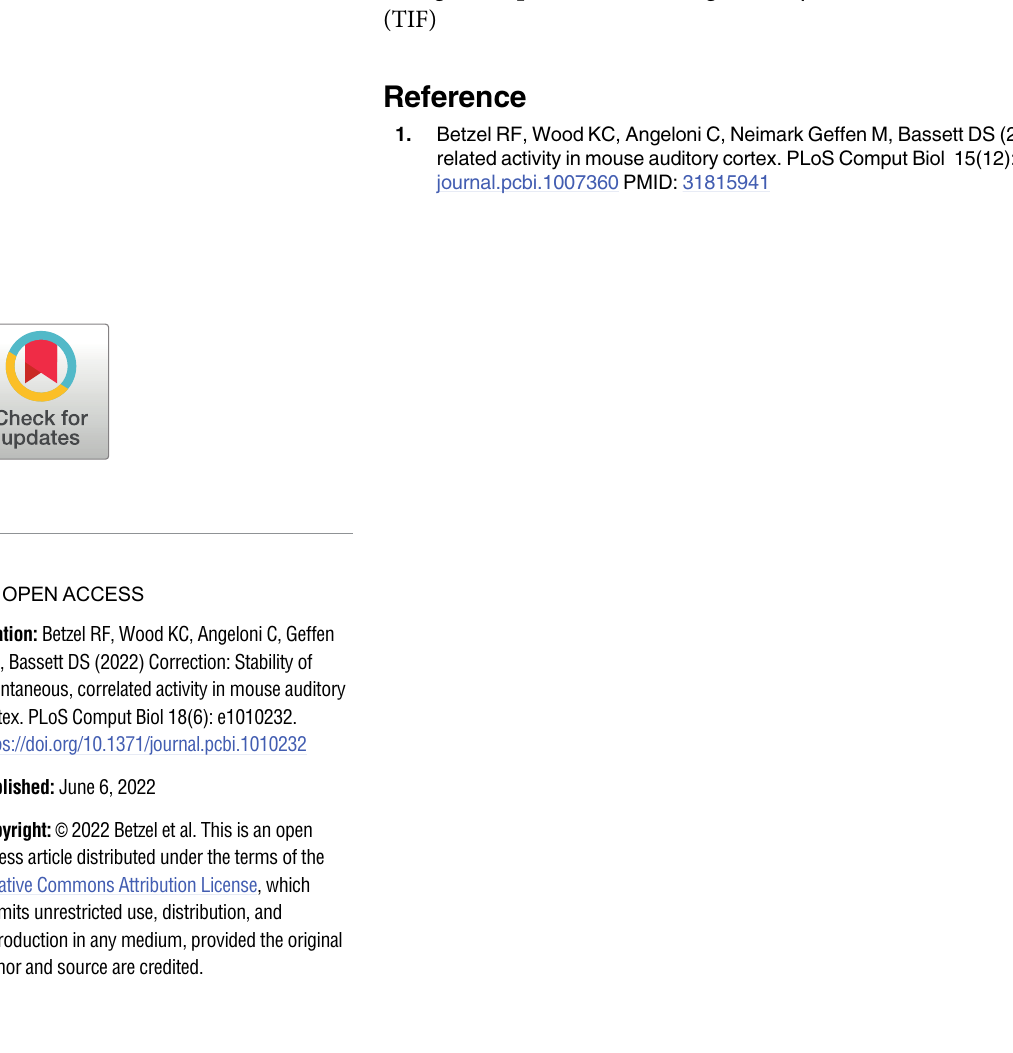
S1 Fig. Module similarity at different hierarchical levels. S2 Fig. Examples of cell tracking over